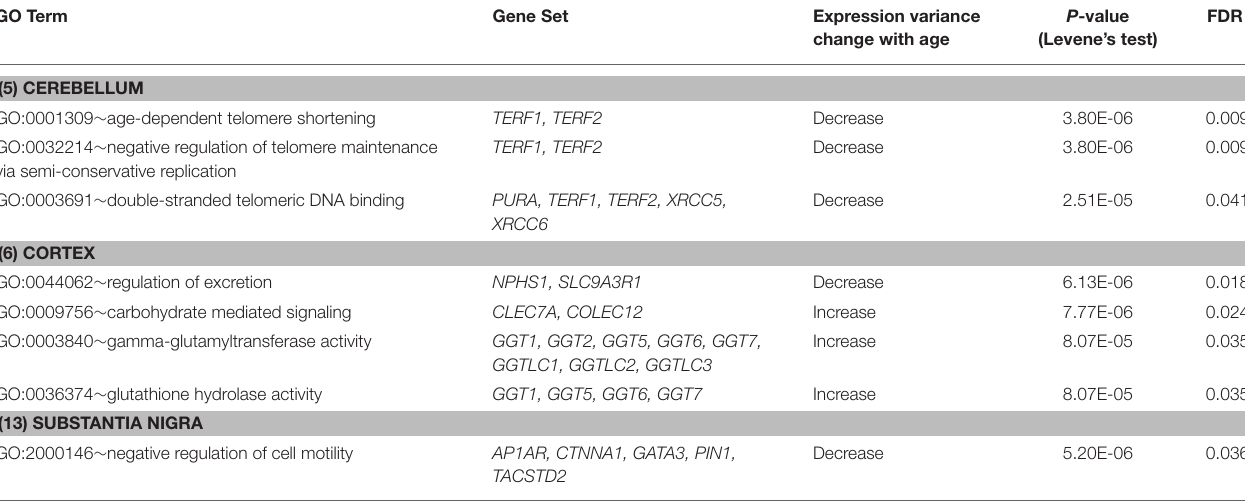
TABLE 3 | DV gene sets showing significant differential variability in brain region-specific expression between age groups (FDR < 5%). GO Term Gene Set Expression variance